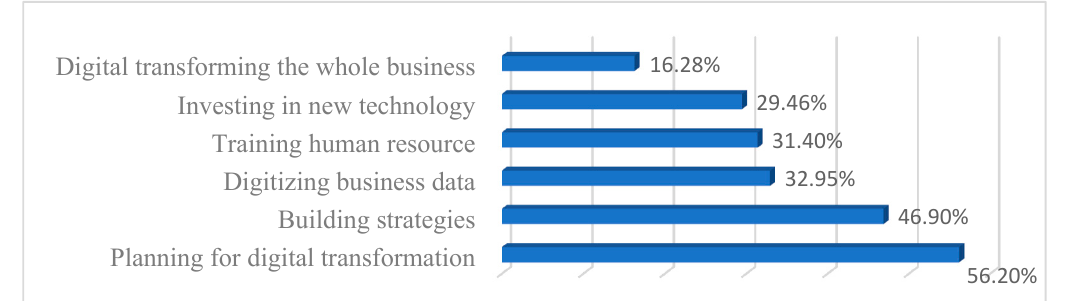
Figure 3. Steps to implement digital transformation.